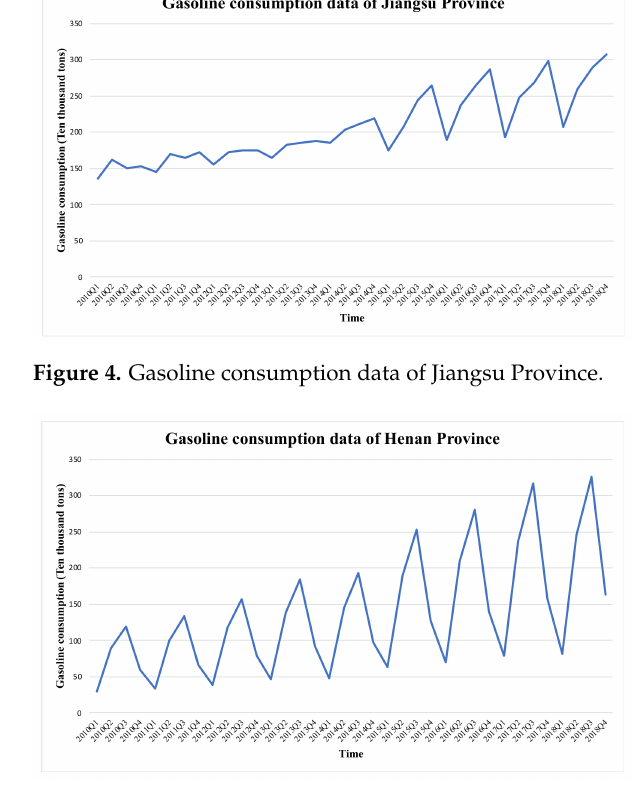
Figure 5. Gasoline consumption data of Henan